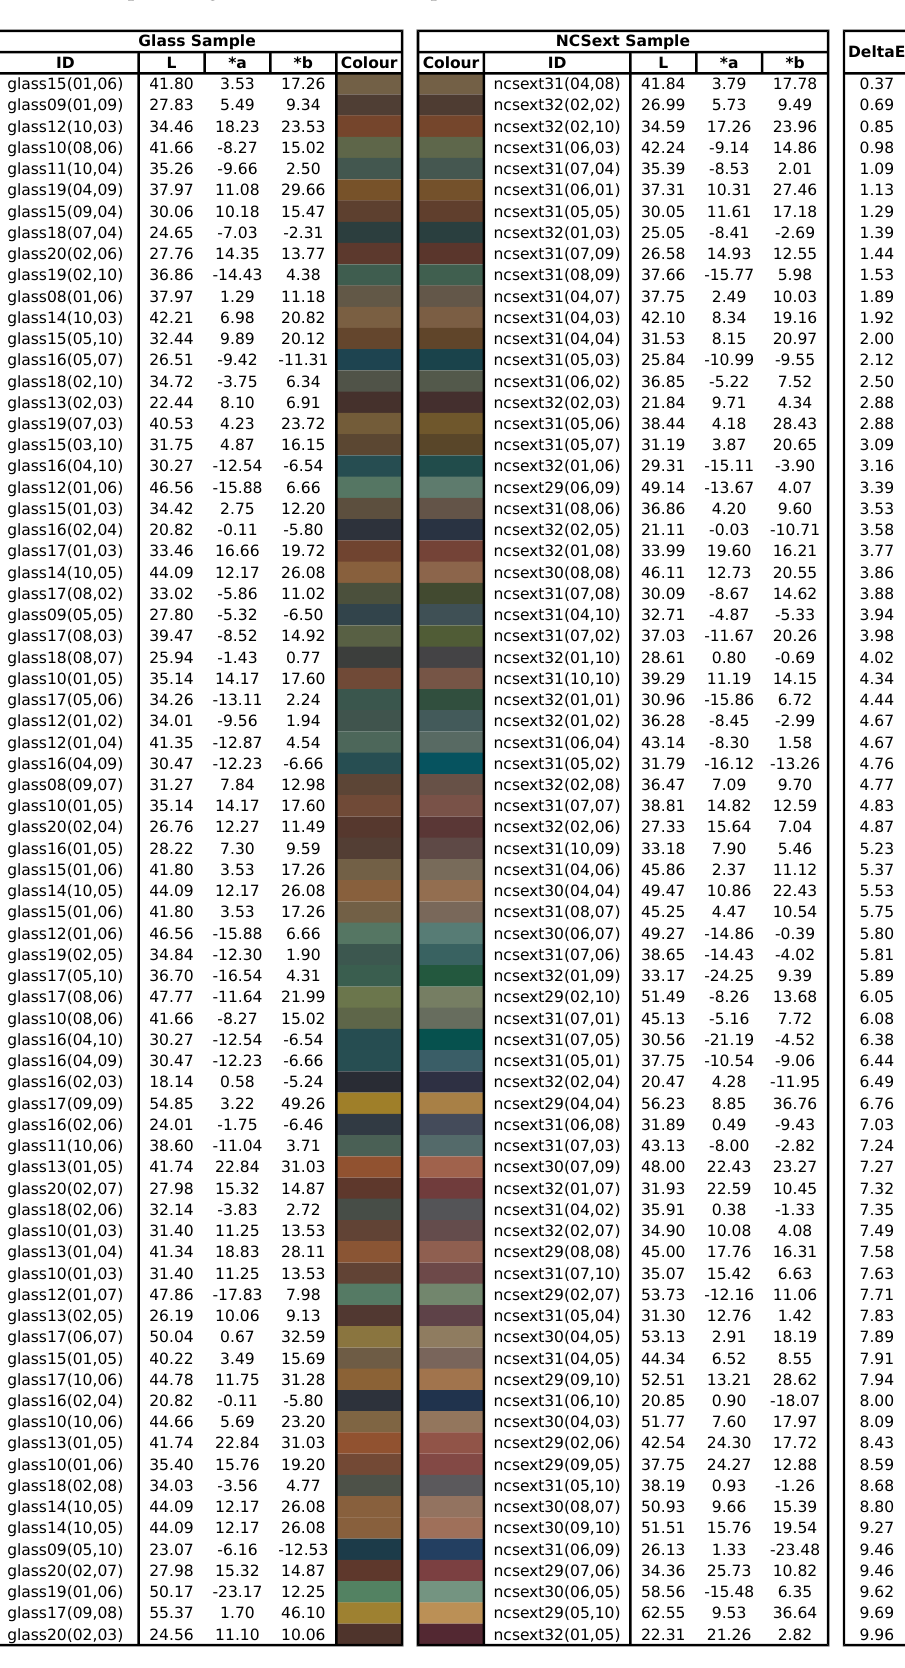
Table 1. Computed matches for a colour difference threshold of τ = 10 as output by our matching script. The actual printed glass colours for the top 20 matches ( ∆ E < 3.5) are shown in Table